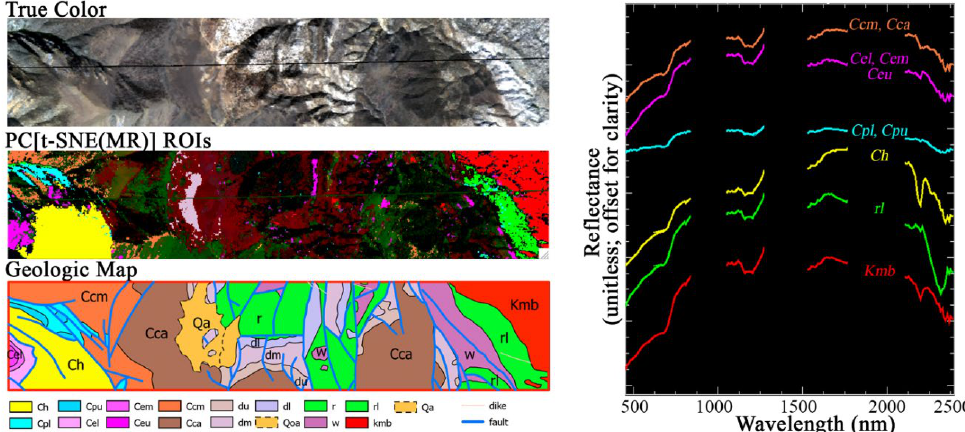
Figure 8. Clusters in PC[t-SNE(MR)] feature space frequently correspond to mapped geologic units. When viewed in map space ( center left ), pixel clusters from Figure 7 correspond well to mapped geologic units ( bottom left ), yielding significantly more information than the true color imagery ( top left ) routinely used for current geologic mapping and reconnaissance. Average reflectance spectra from each pixel cluster ( right ) show clear differences in narrow SWIR absorptions, which provide a mechanistic geophysical explanation of the observed spectral separability among classes. The colors of spectra and pixel clusters are identical to Figure